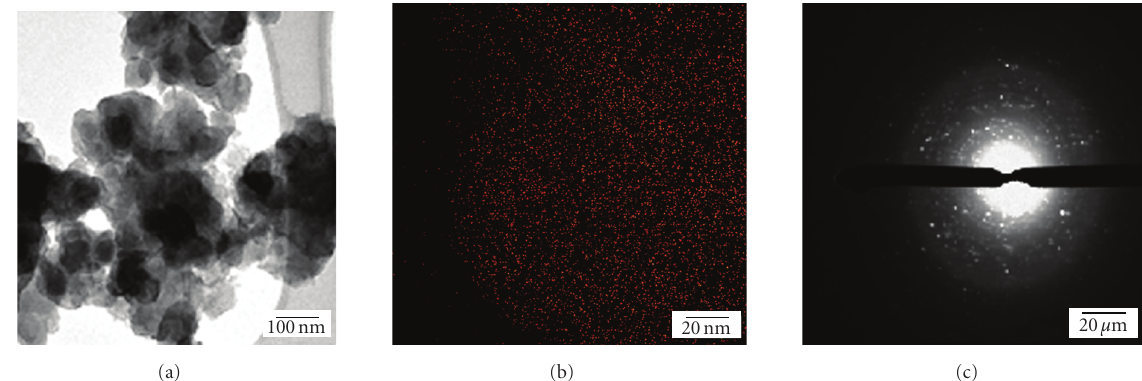
Figure 3: Transmission electron micrograph showing (a) particle morphology and size distribution of C-LiFePO 4 composite material, (b) C Elemental mapping of LiFePO 4 , and (c) selected area electro di ff raction (SAED) pattern of C-LiFePO 4 .